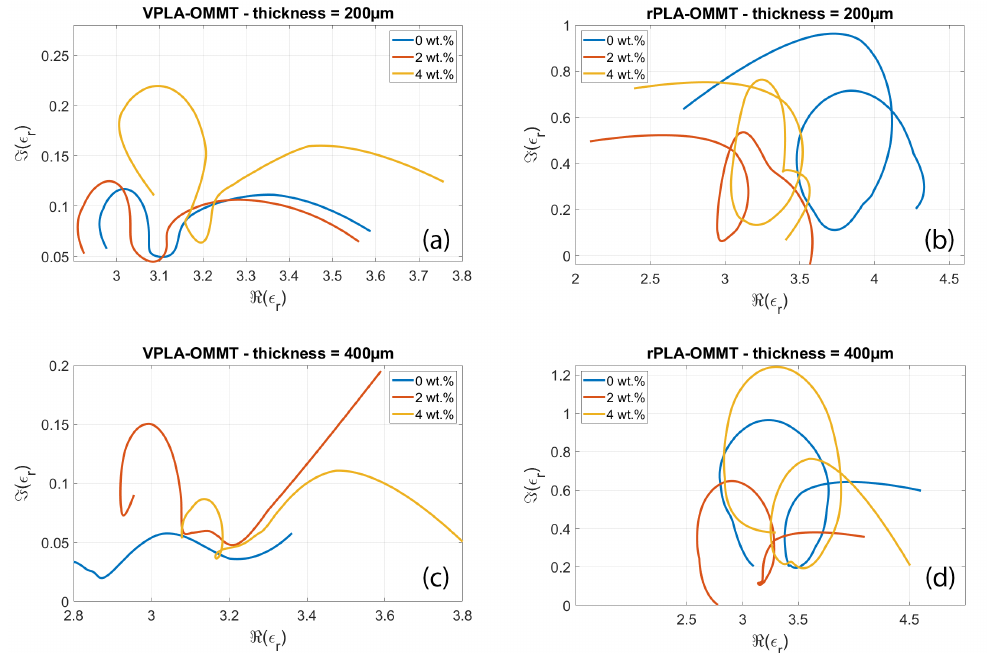
Figure 6. Cole-Cole plot of permittivity for virgin and recycled PLA having various wt.% con- centration in OMMT. ( a ) virgin PLA 200 µm-thick; ( b ) recycled PLA 200 µm-thick; ( c ) virgin PLA 400 µm-thick; and ( d ) recycled PLA 400